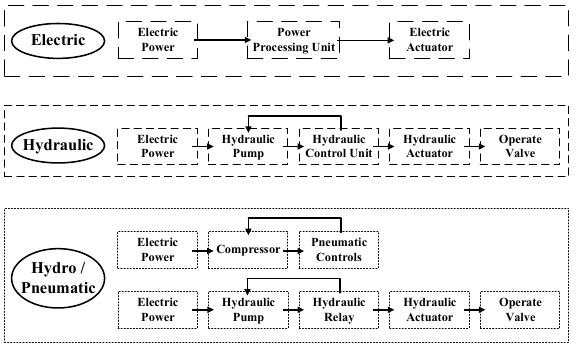
Figure 2: Comparison of complexity levels of popular actuation systems (Rivenbark et al.,